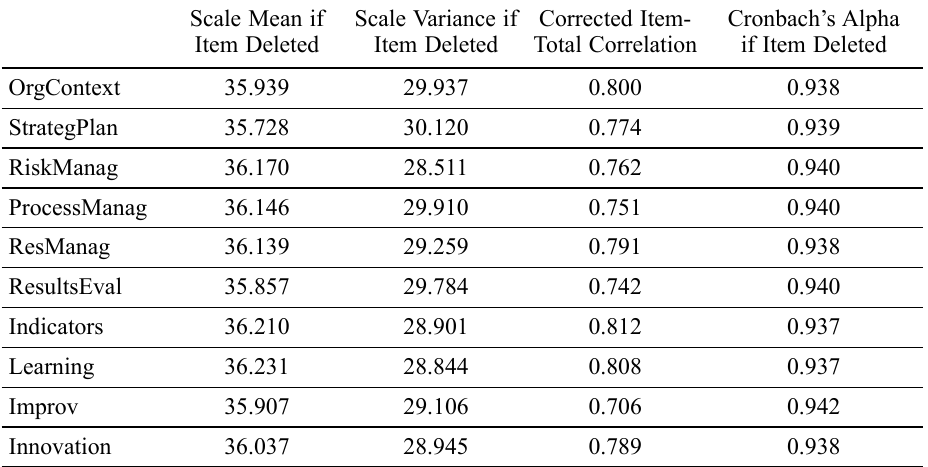
Table 2. Item-total